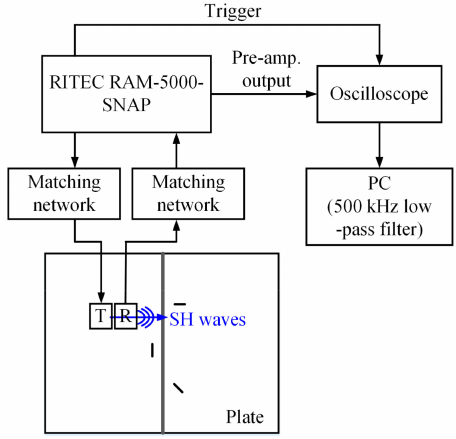
Figure 13. Schematic of the experimental setup to evaluate EMAT’s notch sensitivity.